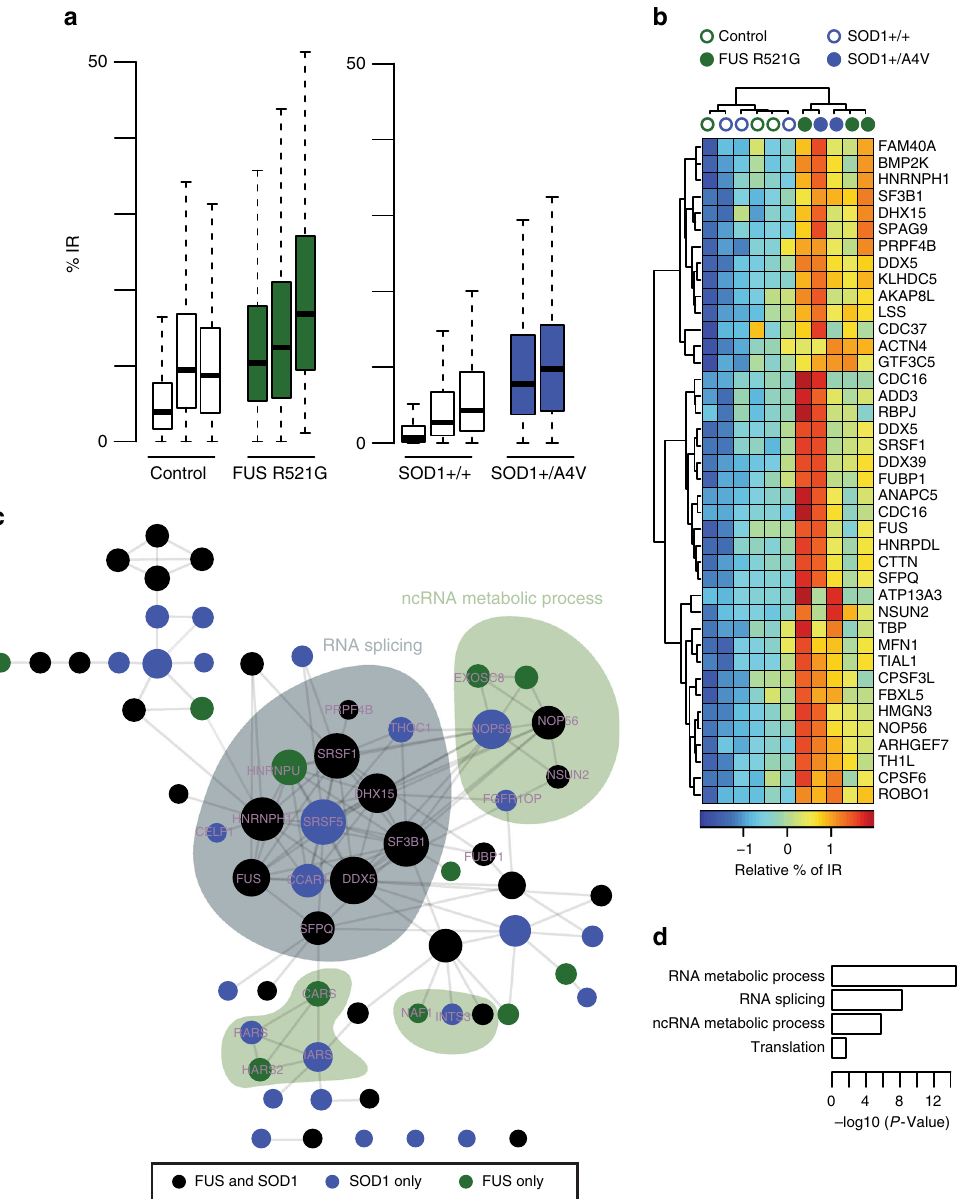
Fig. 2 Transcripts involved in neural induction exhibit widespread intron retention in MNs derived from FUS and SOD1 ALS-causing mutations. a Boxplots displaying the distribution of percentage retention for 167 manually curated introns in control MNs (white box), FUS mu mutant MNs (grey box) or SOD1 mu MNs samples (blue bar) 28,50 . Mutant samples exhibit systematically a higher proportion of IR compared with controls. Boxplots are as shown in Fig. 1h. b Hierarchically clustered (Manhattan distance and Ward clustering) heatmap of relative IR levels in 40 genes showing statistically signi fi cant retention during motor neurogenesis in both SOD1 mu and FUS mu MNs. Blue circles = SOD1 mu samples, grey circles = FUS mu samples and empty circles = control samples. c Network of protein – protein interactions for genes exhibiting IR during motor neurogenesis in either SOD1 mu or FUS mu MNs. Edges represent experimentally determined protein – protein interactions annotated in the STRING database 51 . Nodes indicate proteins, coloured according to the conditions in which the corresponding transcript displays IR; circle sizes are in proportion to the number of edges in the network. d Bar graphs showing the enrichment scores ( P -value from Fisher count test) of GO biological pathways associated with genes that exhibit IR during motor neurogenesis in SOD1 mu and/or FUS mu MNs compared with